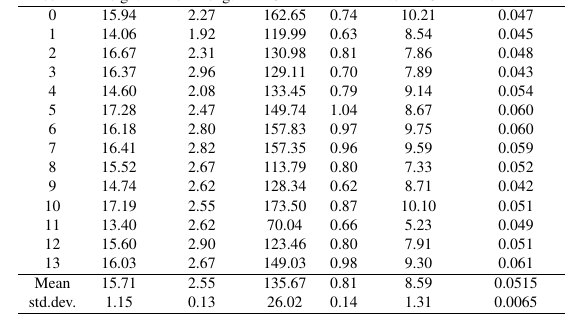
Table 2: Tree parameter estimation results from the trees of